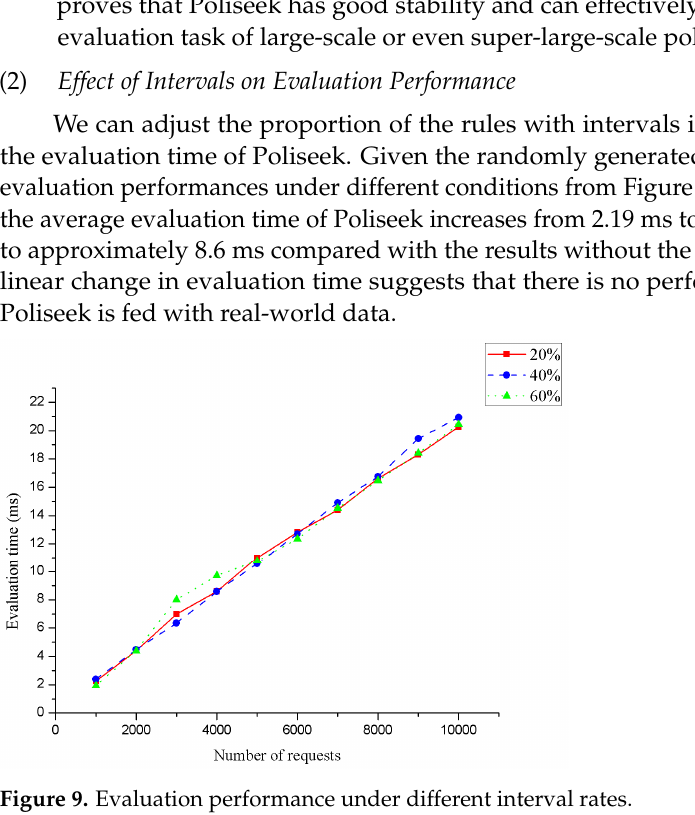
Table 3. Average Evaluation Time of Different Interval Rates. (Evaluation time: ms)